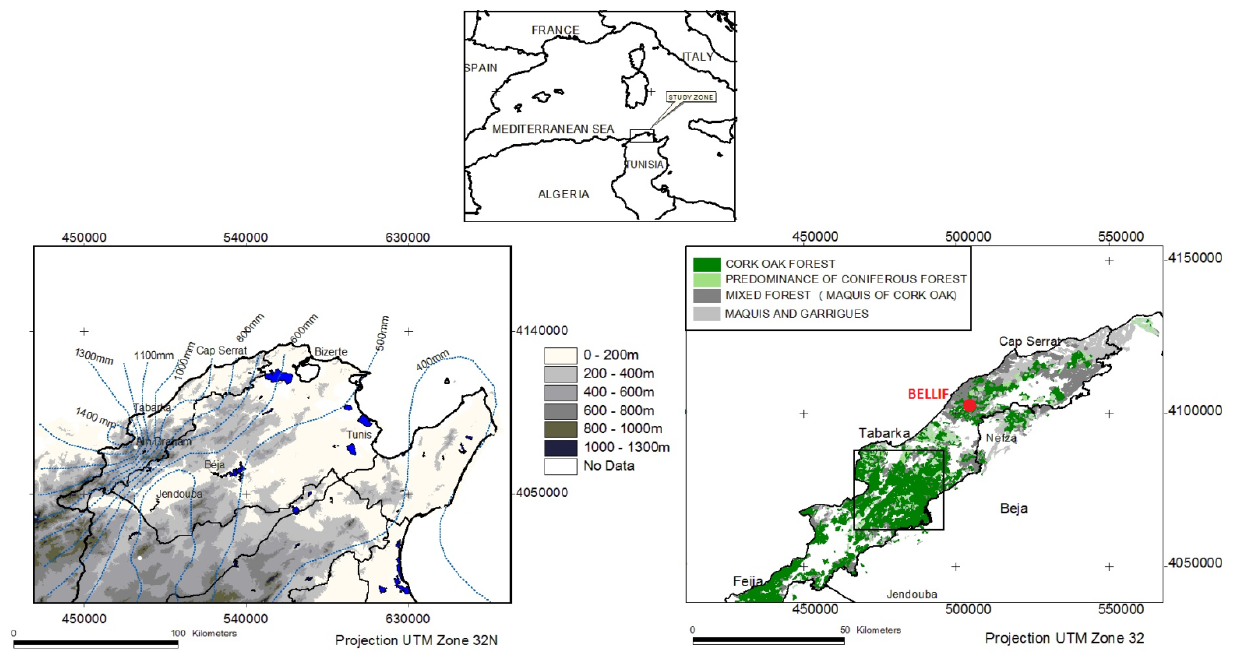
Figure 1. Location of the study area (Bellif national forest) in the Mediterranean basin. Altitude and precipitation isohyets (left) and forest cover types (right) are also shown.